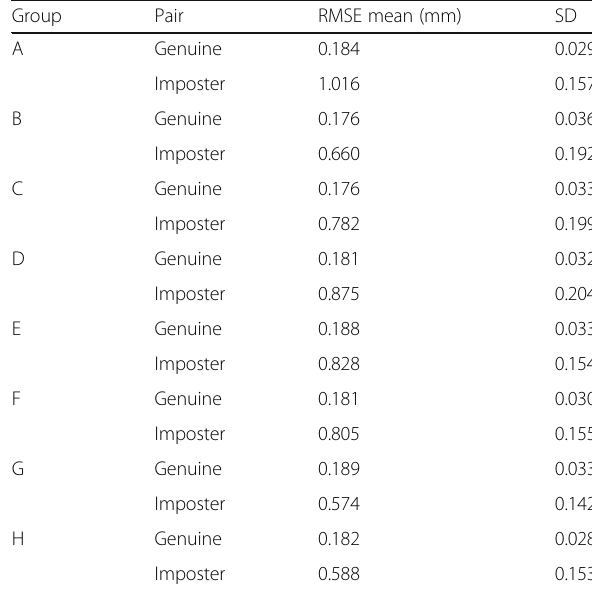
Table 1 Descriptive statistics of the genuine and the